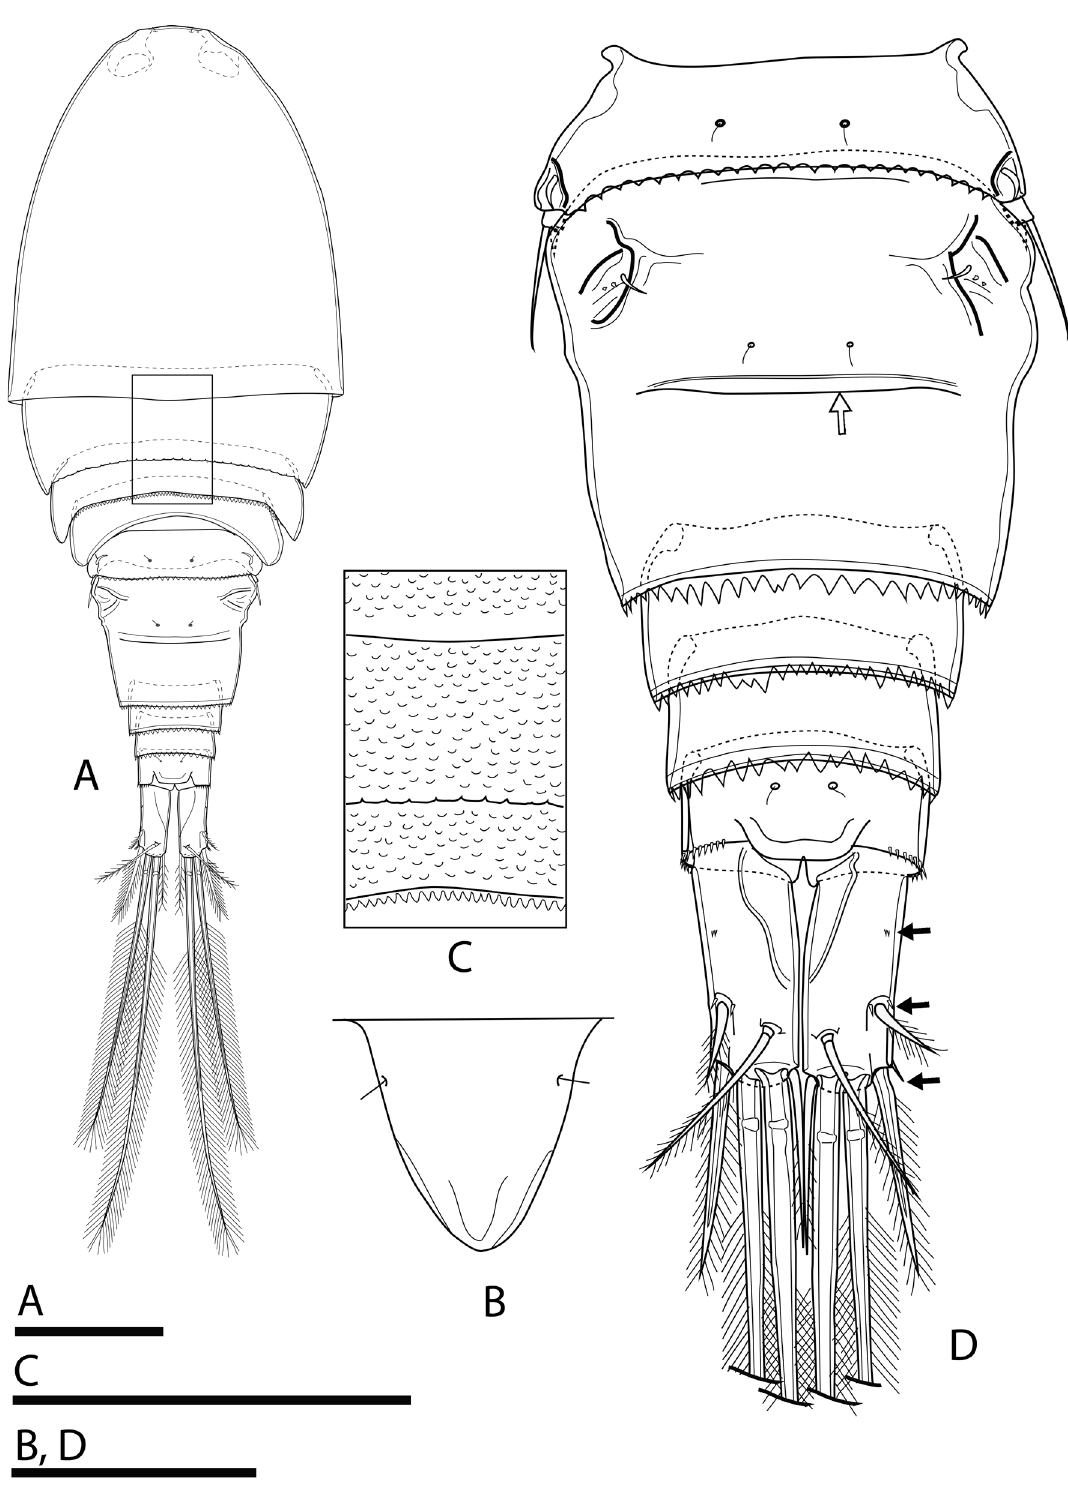
Fig. 2. Metacyclops sakaeratensis sp. nov., paratype, ♀ (A, C; ZMB 34230) and holotype, ♀ (B, D; ZMB 34230 slide No. 5120). A . Habitus, dorsal view. B . Rostrum, frontal view. C . Integumental pits and posterior margins of cephalothorax and two subsequent pedigerous somites, dorsal view. D . Urosome, dorsal view (black and open arrows indicate spinules and transverse suture, respectively). Scale bars: A, C = 100 μm; B, D = 50